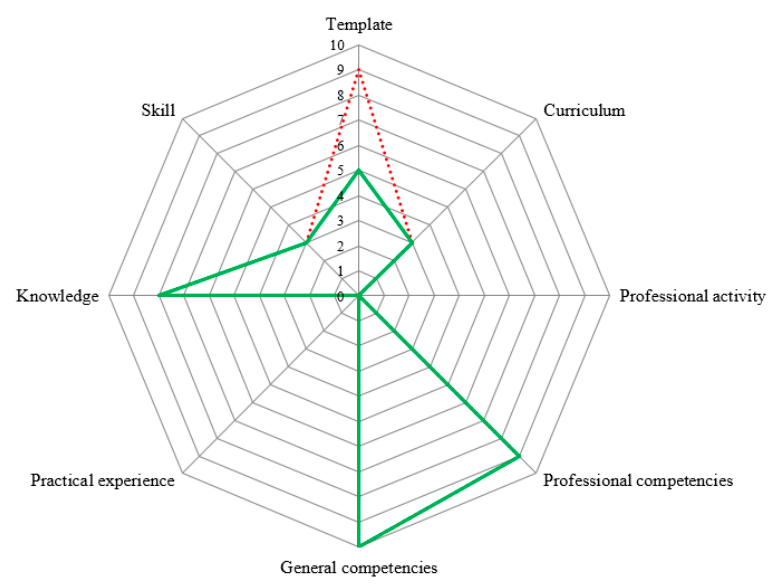
Figure 4. The example of a diagram obtained as a result of aspect assessment.